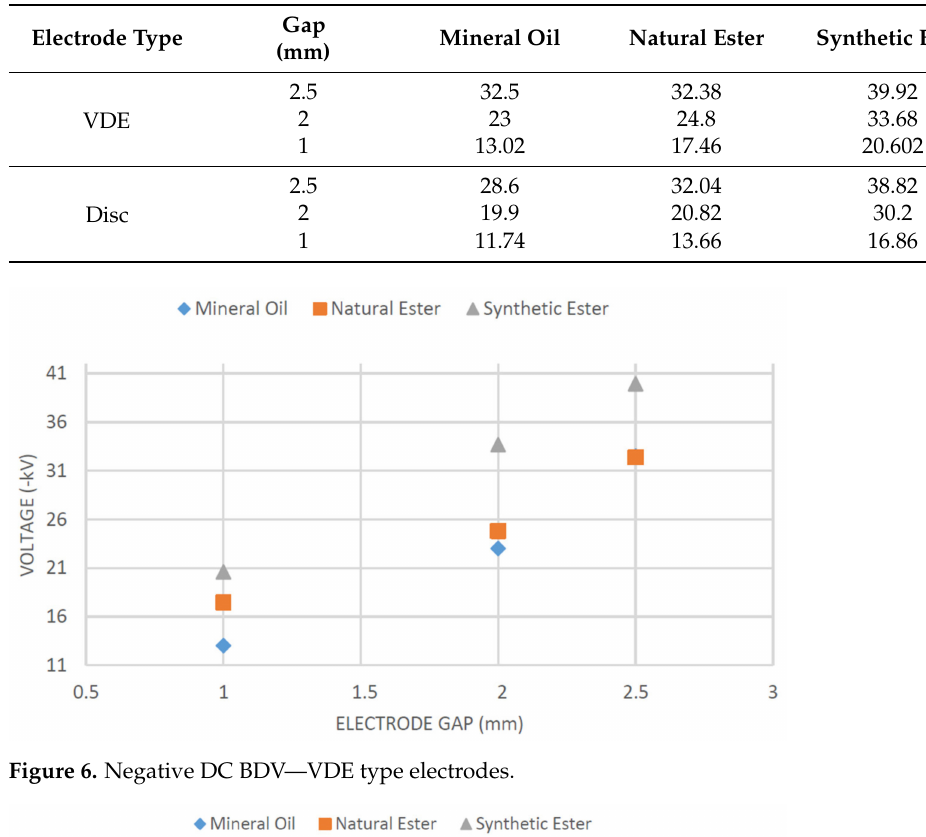
Table 5. Negative DC BDV values.